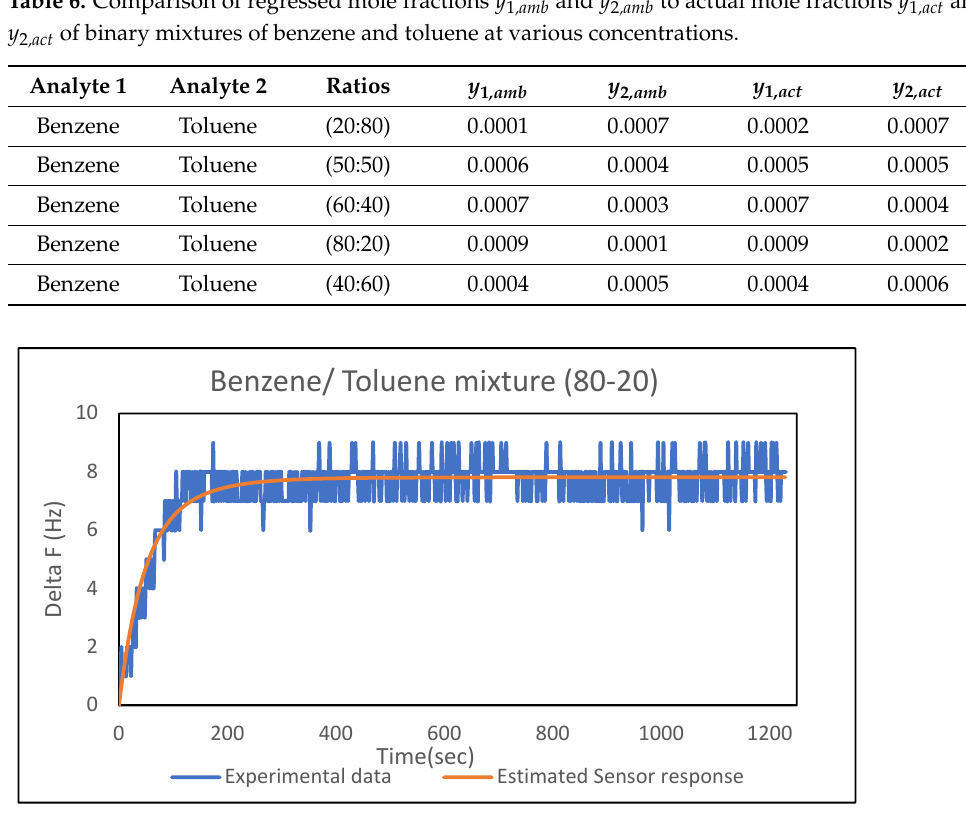
Figure 3. Comparison of experimental data and estimated sensor response for an 80–20 benzene– toluene binary mixture in a PEMA–DIOA (10%) film.